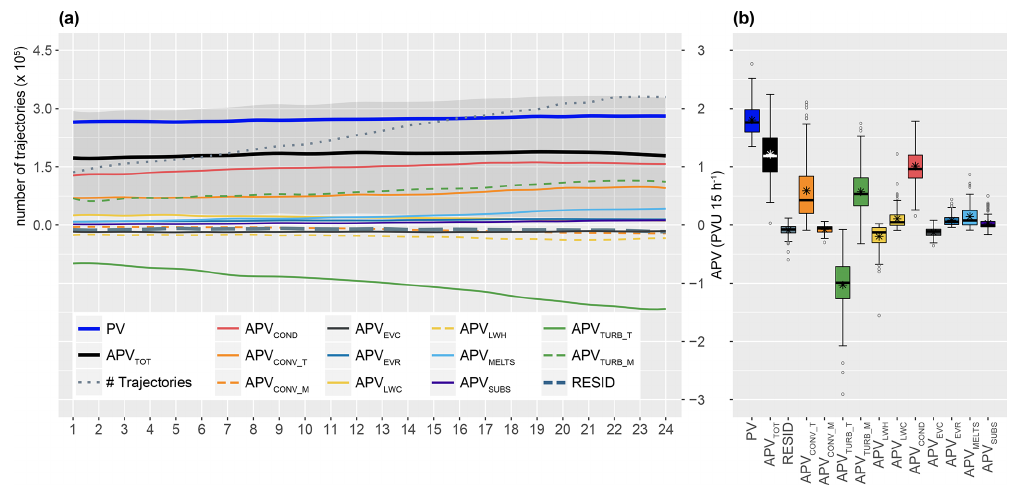
Figure 3. Physical processes that contribute to the positive PV anomaly (PV ≥ 1PVU) in the cyclone center between the surface and 550hPa during the 24h period of most rapid cyclone intensification. (a) Time series of APV averaged over the 144 cyclones of the cold season and (b) distribution of APV tendencies in individual cyclones averaged over the 24h intensification period. The interquartile range is shown by the boxes, the whiskers extend 1.5 times the interquartile range, the median is shown by the bold horizontal line and the mean by the star, and outliers are shown as open